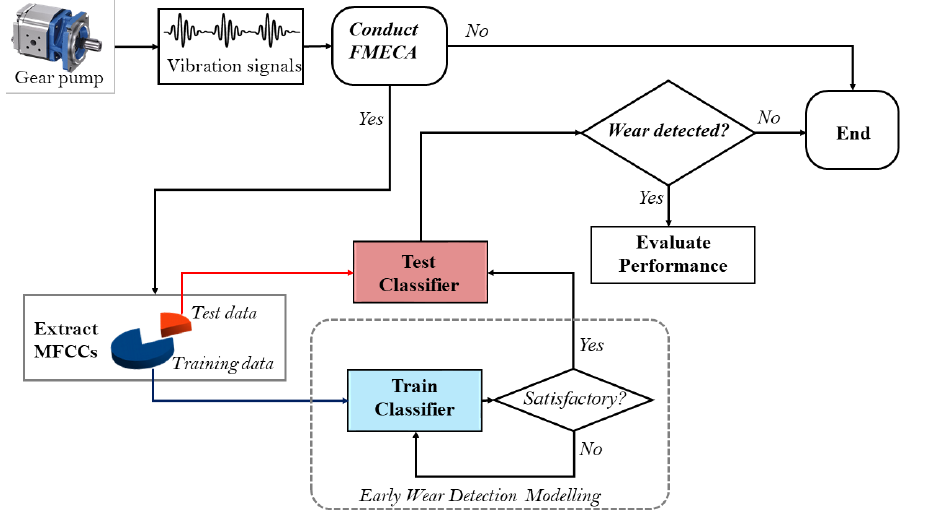
Figure 8. Proposed wear detection